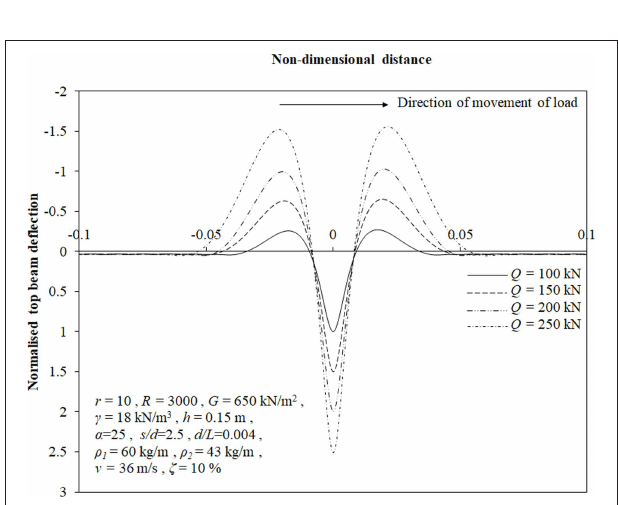
FIGURE 6 | Deflection of top beam for various magnitudes of applied